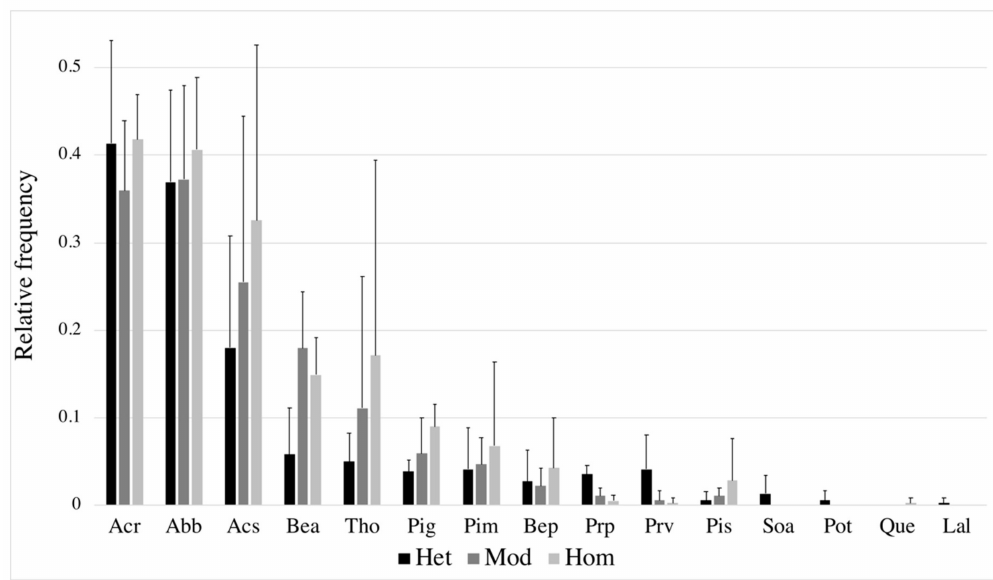
Figure 4. Relative frequencies of the tree seedling species in the three di ff erent landscape heterogeneity levels (heterogeneous (Het, n = 4), moderate (Mod, n = 4), homogenous (Hom, n = 4)). Error bars represent confidence intervals ( alpha = 0.05%). Acr: Acer rubrum ; Abb: Abies balsamea ; Acs: Acer saccharum ; Bea: Betula alleghaniensis ; Tho: Thuya occidentalis ; Pig: Picea glauca ; Pim: Picea mariana ; Bep: Betula papyrifera ; Prp: Prunus pensylvanica ; Prv: Prunus virginiana ; Pis: Pinus strobus ; Soa: Sorbus americana ; Pot: Populus tremuloides ; Que Quercus rubra ; Lal: Larix laricina .